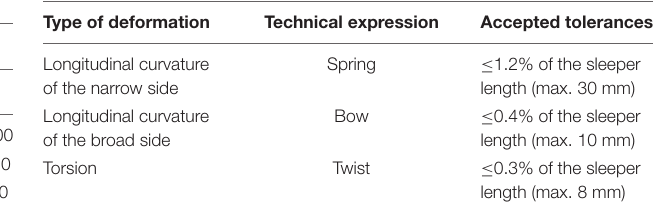
TABLE 2 | Accepted tolerances given by the Austrian Federal Railways regarding the deformation of Beech